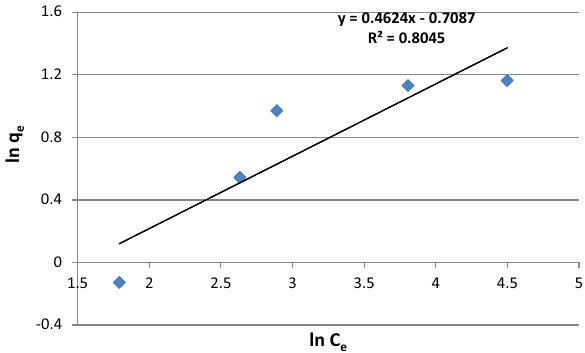
Fig. 12 C q C e / e versus e for Langmuir isotherm application